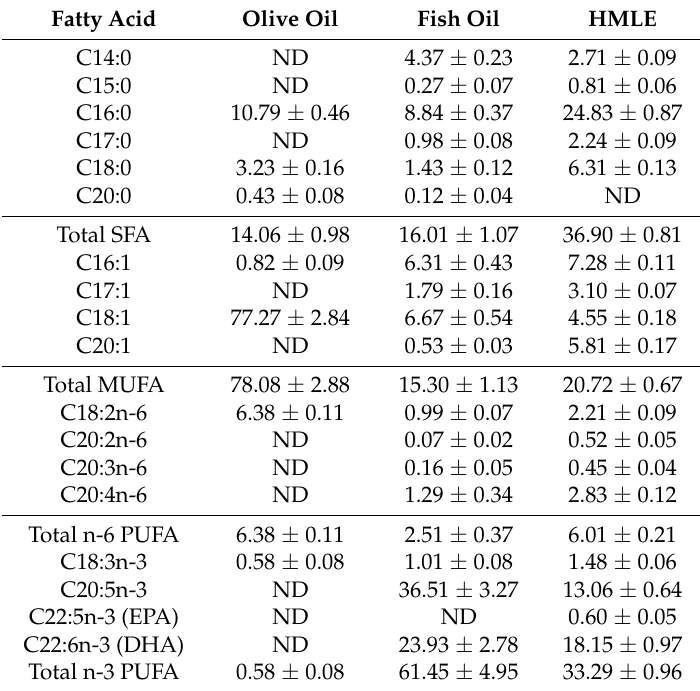
Table 1. Fatty acid composition of olive oil, fish oil, and